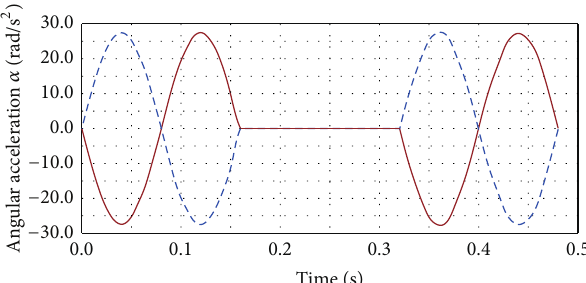
Figure 8: The angular acceleration of BC and B 󸀠 C 󸀠